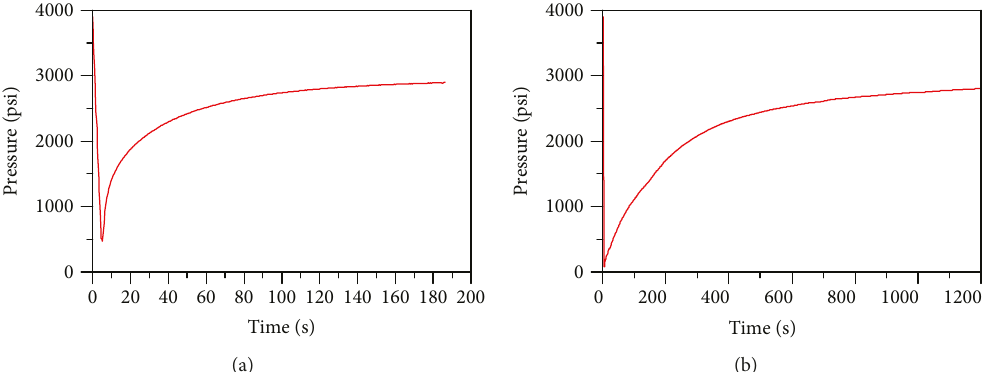
Figure 13: Testing results of pressure response under di ff erent permeabilities. (a) Pressure response versus time (number 1, k = 105 2 mD, q = 1 5 ml/s, t = 5 s). (b) Pressure response versus time (number 2, k = 10 2 mD, q = 0 5 ml/s, t 0